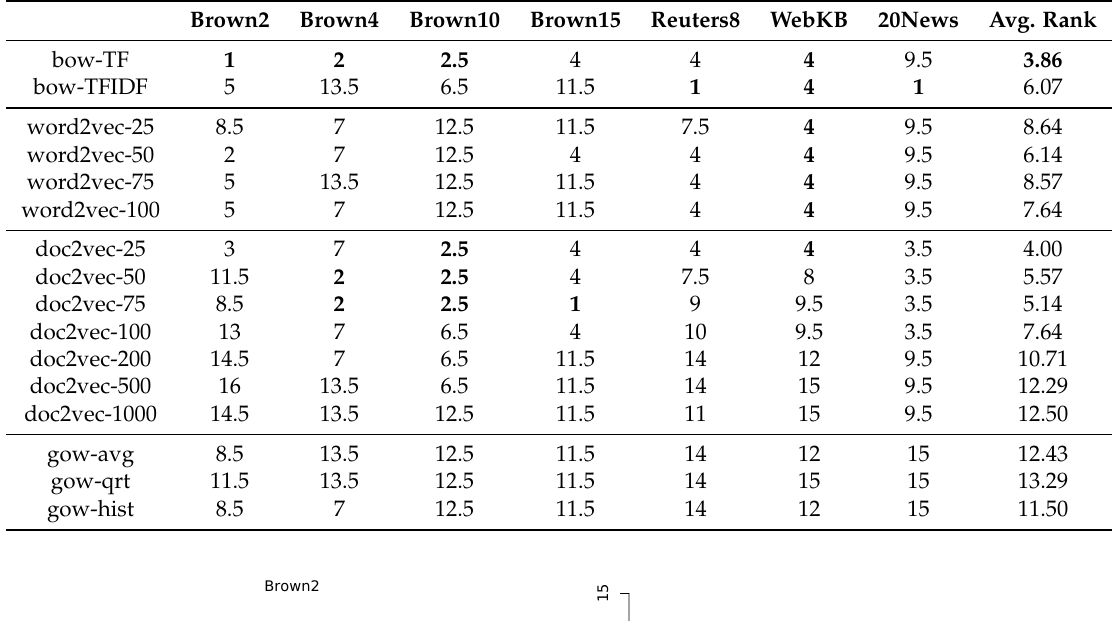
Table 7. Multi-objective ranking of the 16 variants of the three document representation models by document classification task with respect to the F1-score. The last column reports the average rankings over the seven tasks. The top-ranked models in each column are shown in bold.